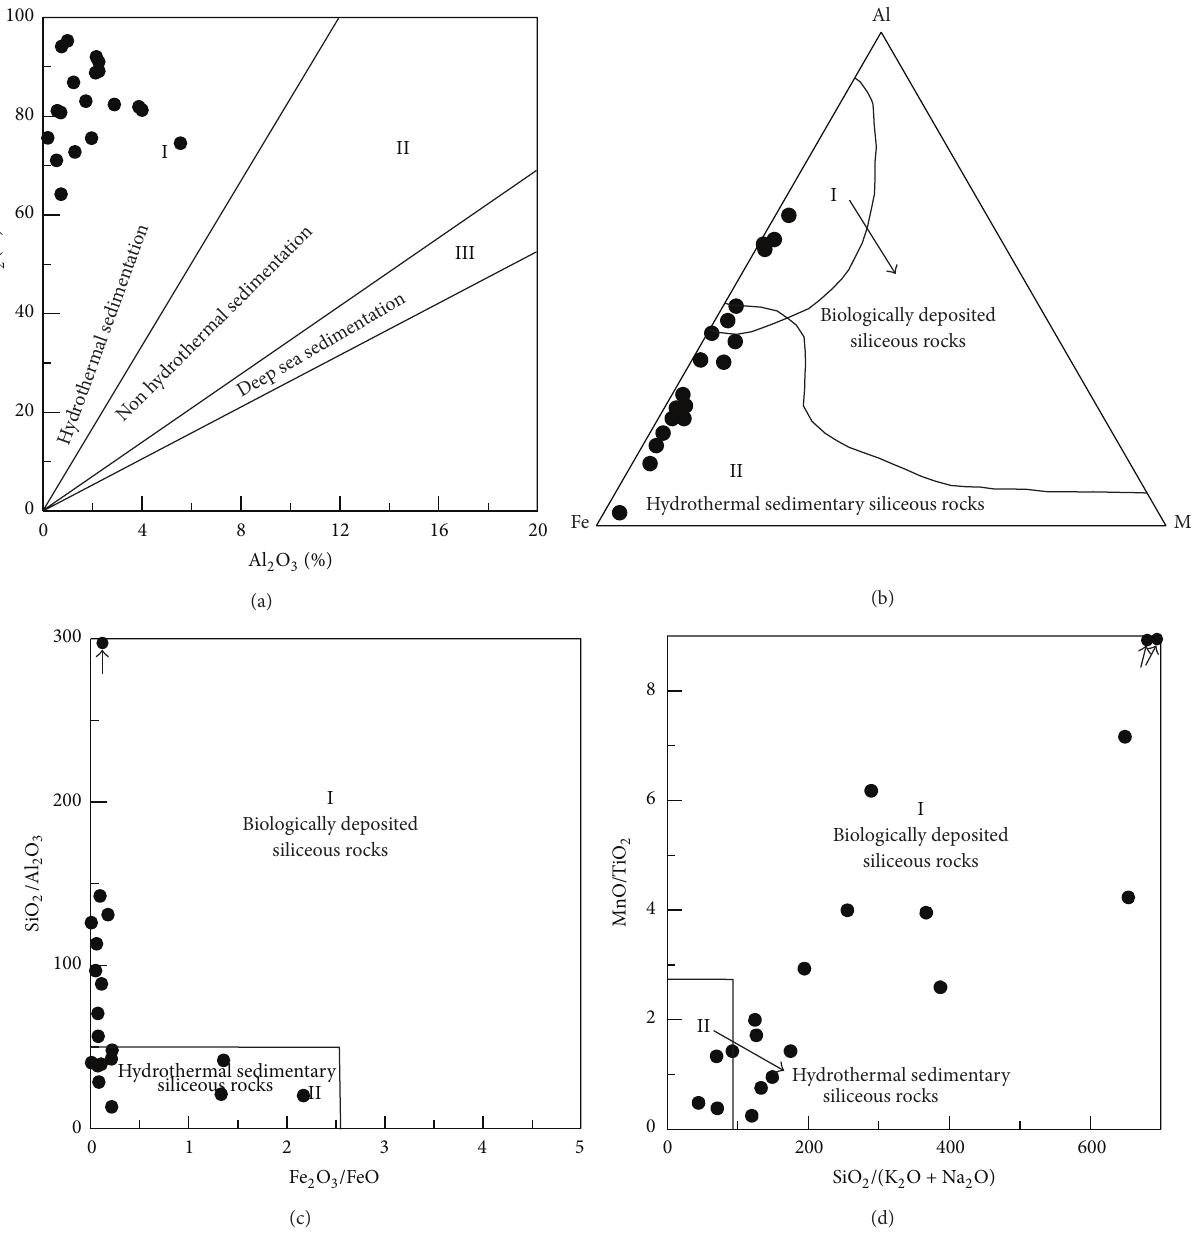
Figure 9: Major element discrimination diagrams supporting hydrothermal and biological processes for the genesis of siliceous rocks of the Bafangshan-Erlihe area (After: (a)—[51]; (b)—[52]; (c); (d)—[53]).